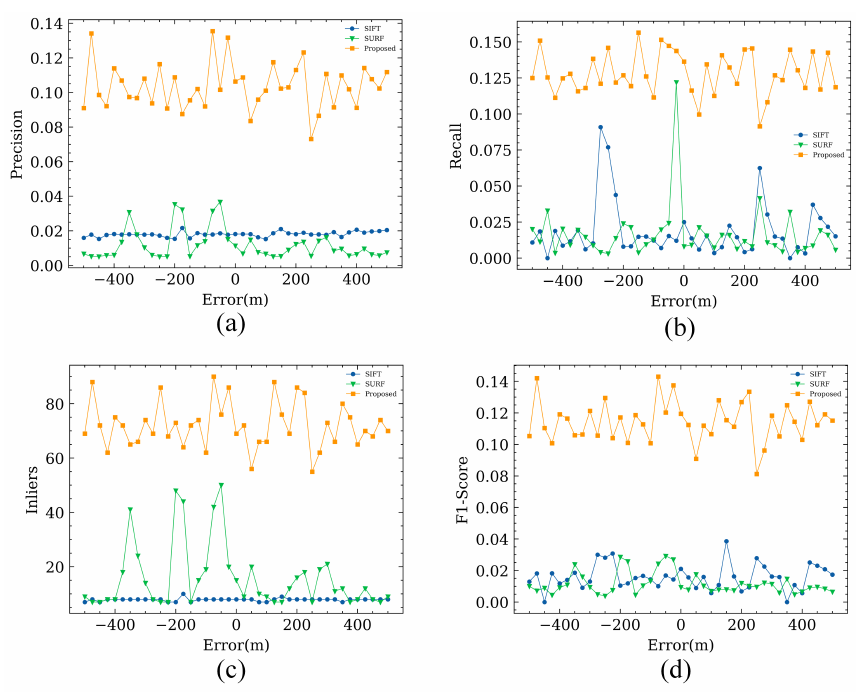
Figure 18. Quantitative comparison of interference fringe-matching algorithms in the position error experiment. ( a ) Precision. ( b ) Recall. ( c ) Inliers. ( d ) F1-Score. Table 3. Average of the quantitative evaluation indicators in the position error experiment. Precision Recall Inliers F1-Score SIFT 0.018 0.019 7.878 0.016 SURF 0.019 0.016 15.780 0.012 Proposed 0.103 0.128 72.024